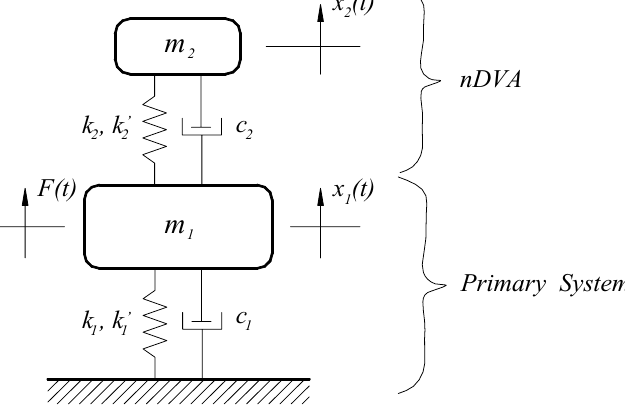
Fig. 1. Two degree-of-freedom mechanical system incorporating